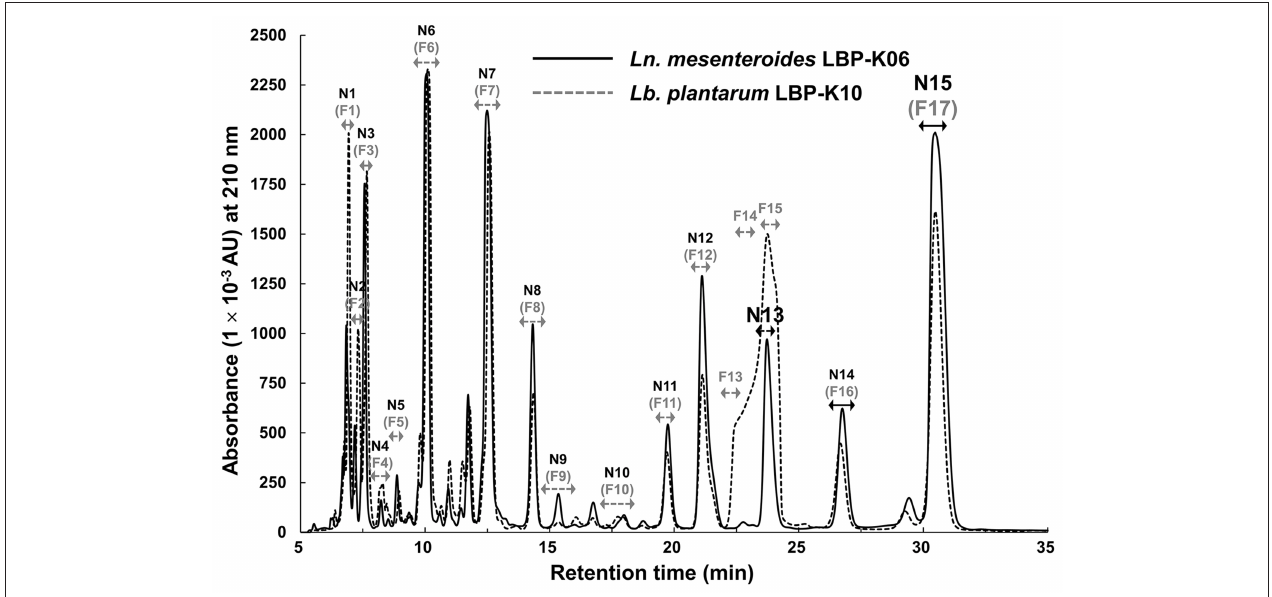
FIGURE 1 | The chromatographic separation of N13 and N15 by Ln. mesenteroides LBP-K06 compared with corresponding fractions of Lb. plantarum LBP-K10. HPLC profiles of both strains were performed at a wavelength of 210 nm. The predominant production of cis -cyclo( L -Leu- L -Pro) (F13) and cis -cyclo( L -Phe- L -Pro) (F17) by Lb. plantarum LBP-K10 was used as a reference experiment.